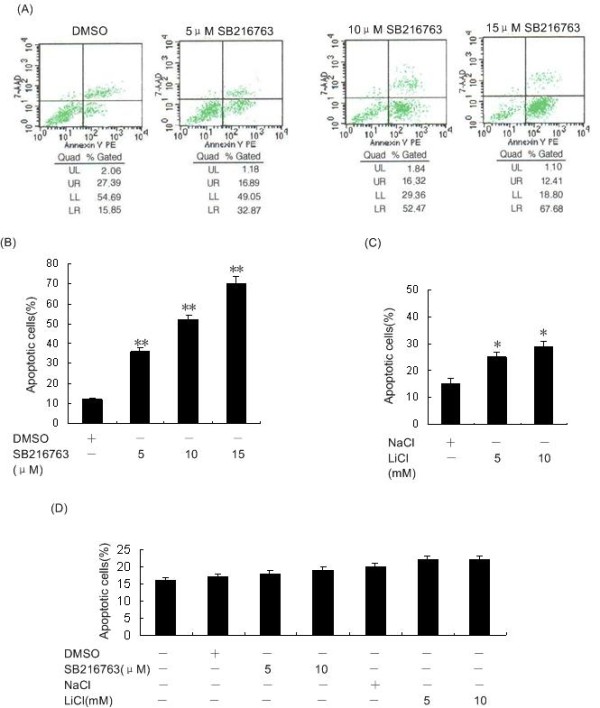
Inhibition of GSK-3β induces apoptosis in ALL but not control cells. (A) ALL cells were treated for 48 h with DMSO or SB216763 at indicated concentrations. Cells were assayed for apoptosis using Annexin V-PE/7-AAD staining by flow cytometry. (B) We found that inhibition of GSK-3β in ALL cells consistently resulted in a dose-dependent increase in the number of apoptotic cells. (C) ALL cells were treated for 48 h with NaCl or LiCl at indicated concentrations, then assayed for apoptosis using Annexin-V-PE/7-AAD staining as determined by flow cytometry. (D) Each GSK-3β inhibitor was added to control BMMC at the initiation of the culture at a variety of concentrations as indicated on the graph. LiCl and SB216763 had no significant effect on cell apoptosis in normal BMMC. Columns, mean; bars, SD. *P < 0.05, **P < 0.01 vs. control. All assays were performed in triplicate.